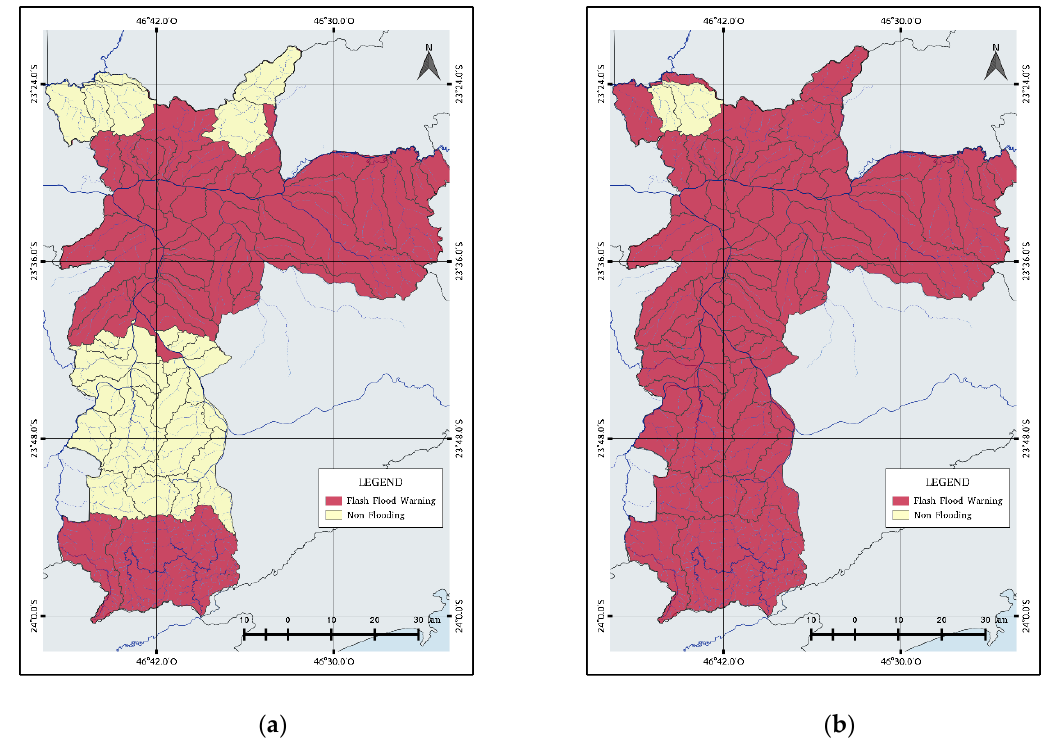
Figure 9. Spatial distributions of ( a ) flash flood warning observations and ( b ) probability of flash flood warnings using the binary logistic model.